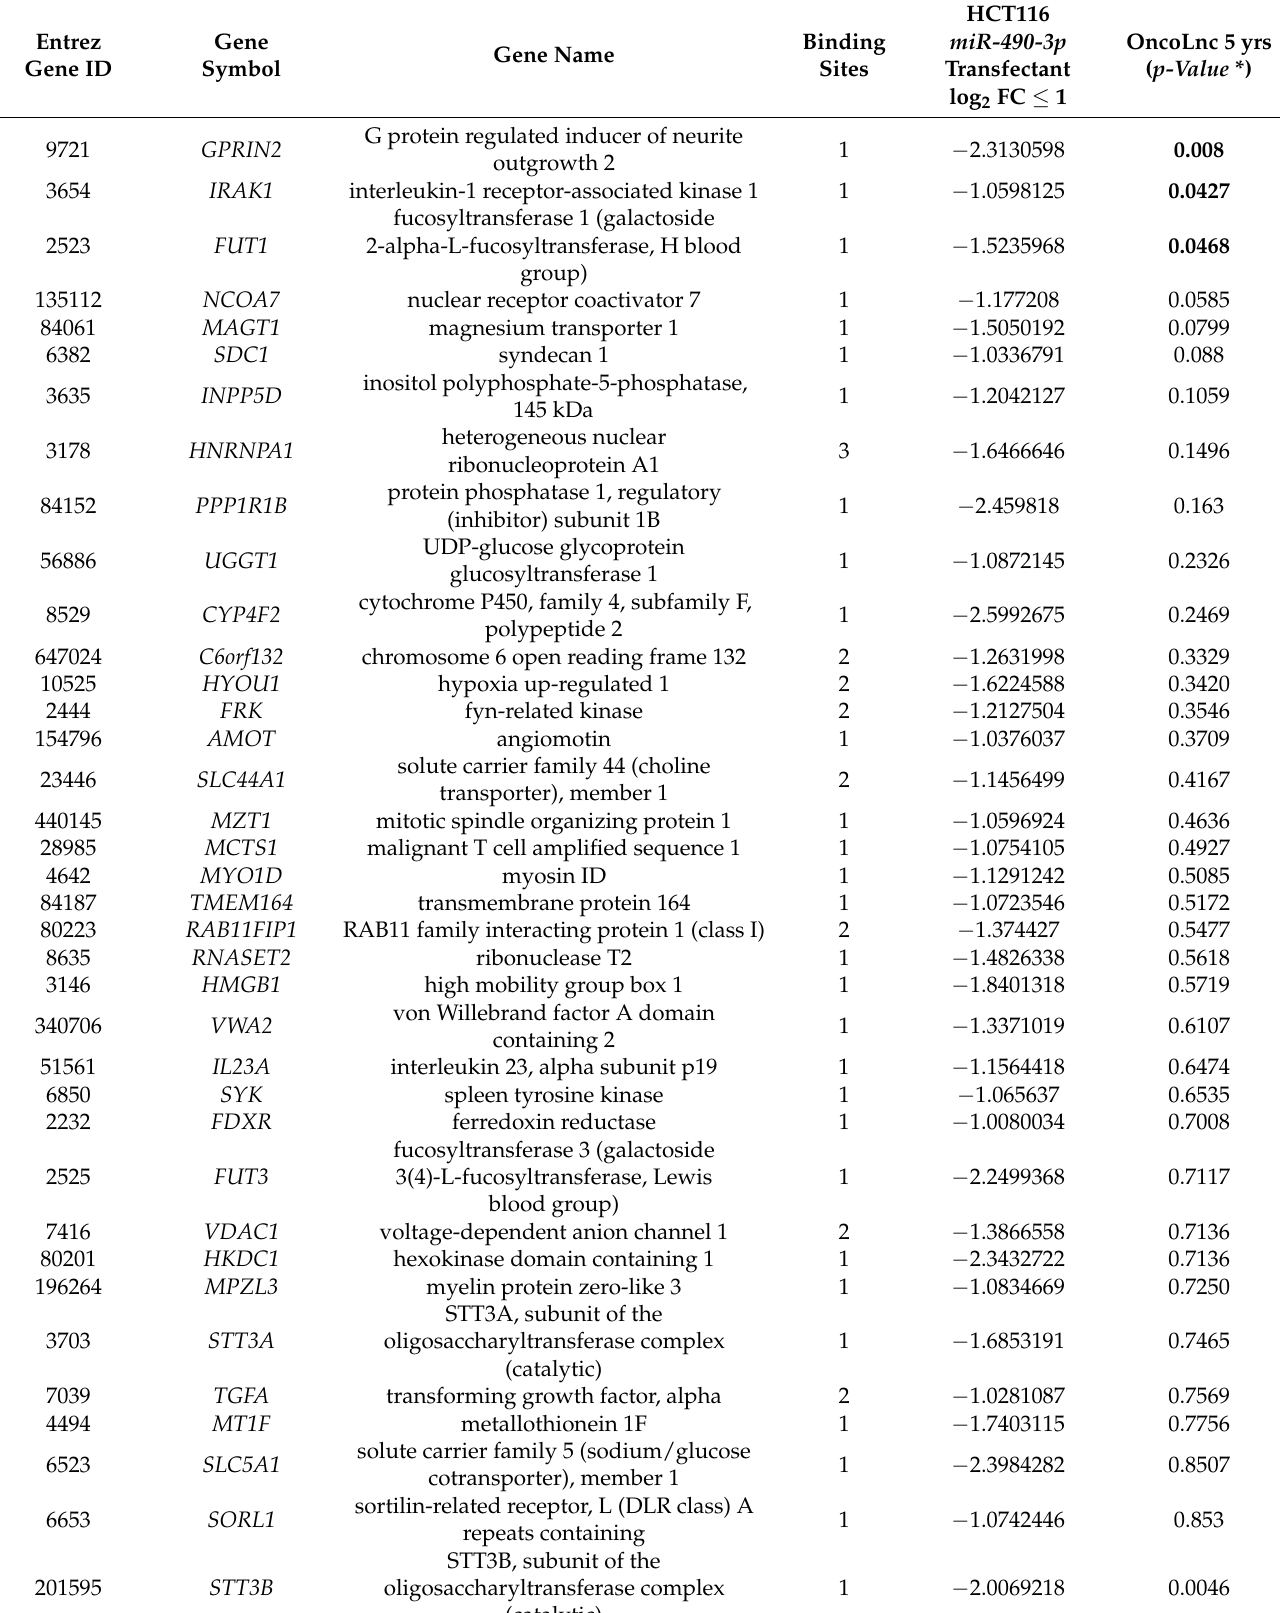
Table 2. Candidate genes of miR-490-3p targets in CRC